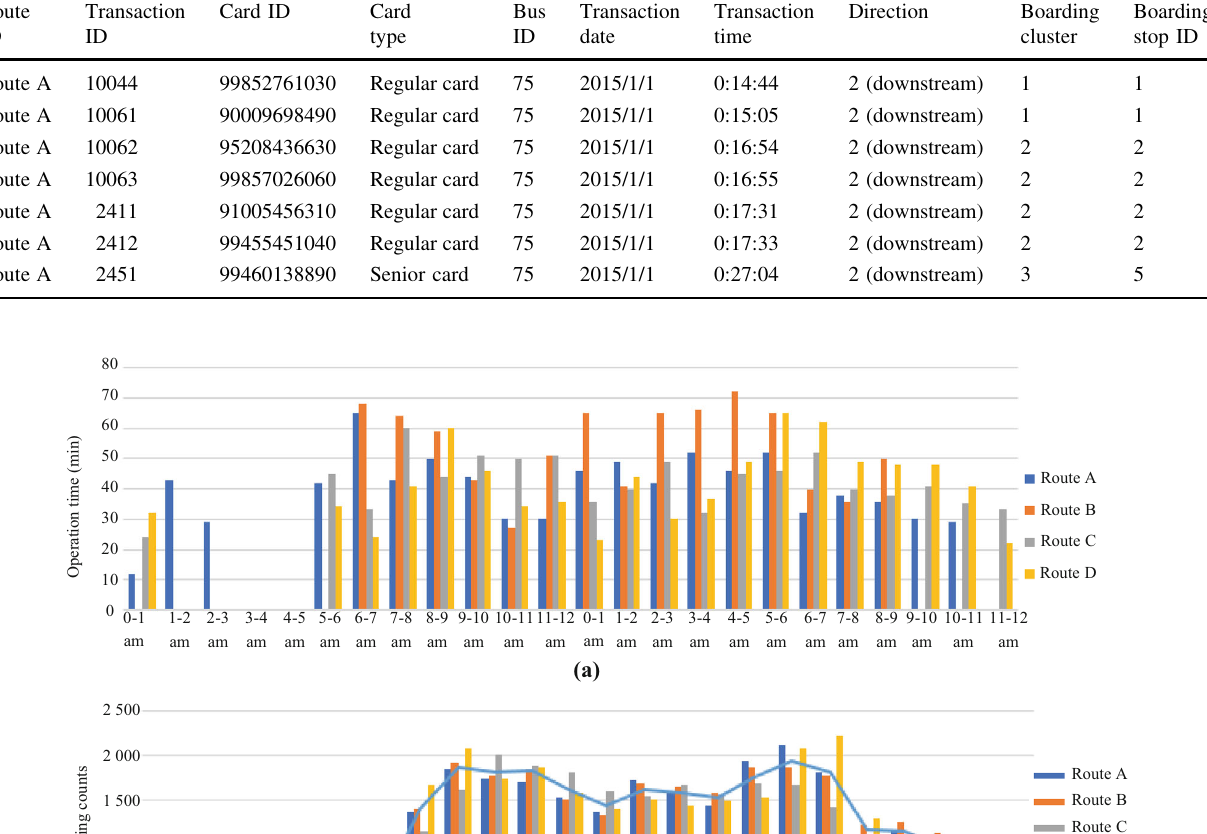
Table 4 An example of the boarding stop identification results